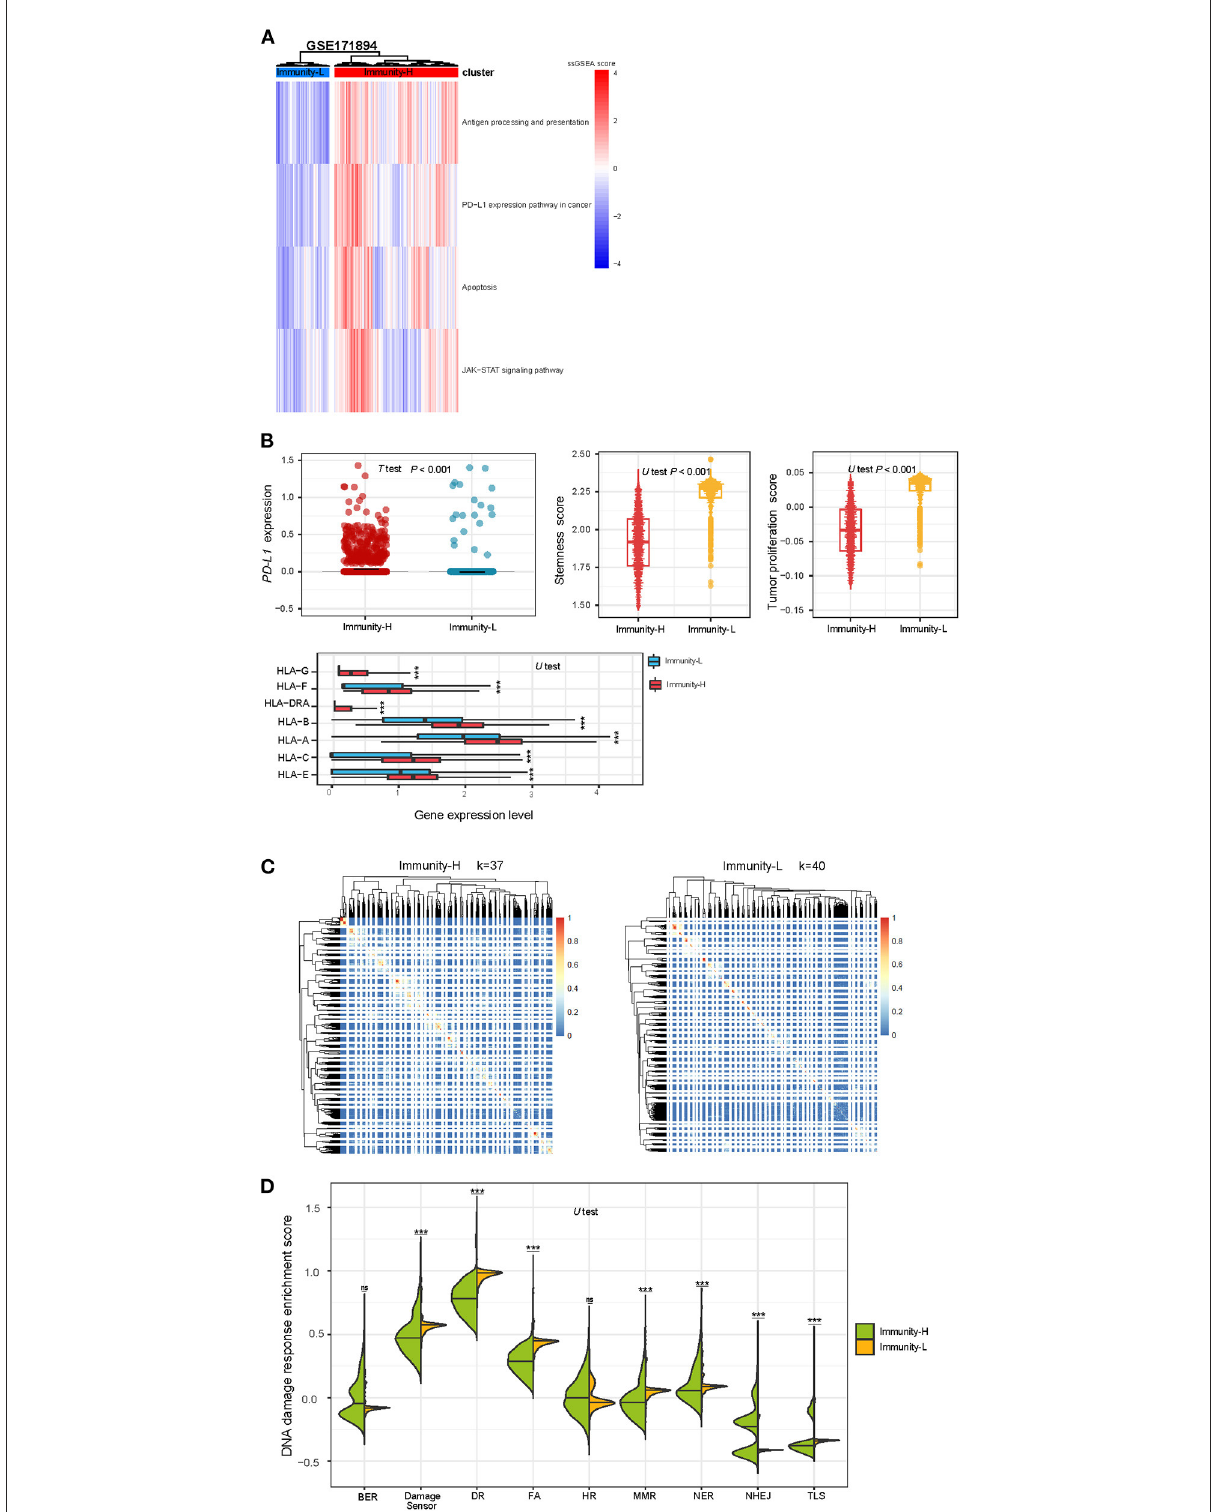
FIGURE5 Validation of the immune-specific subtyping method in HPV + cervical cancer single cells. (A) Hierarchical clustering of 3,356 cancer cells from 2 HPV + cervical cancer patients based on the enrichment scores of four immune-related pathways. (B) The expression levels of PD-L1 and many HLA genes are significantly higher in Immunity-H than in Immunity-L cancer single cells, while tumor stemness and proliferation scores are significantly lower in Immunity-H cancer single cells. (C) Consensus clustering of single cells in Immunity-H and Immunity-L